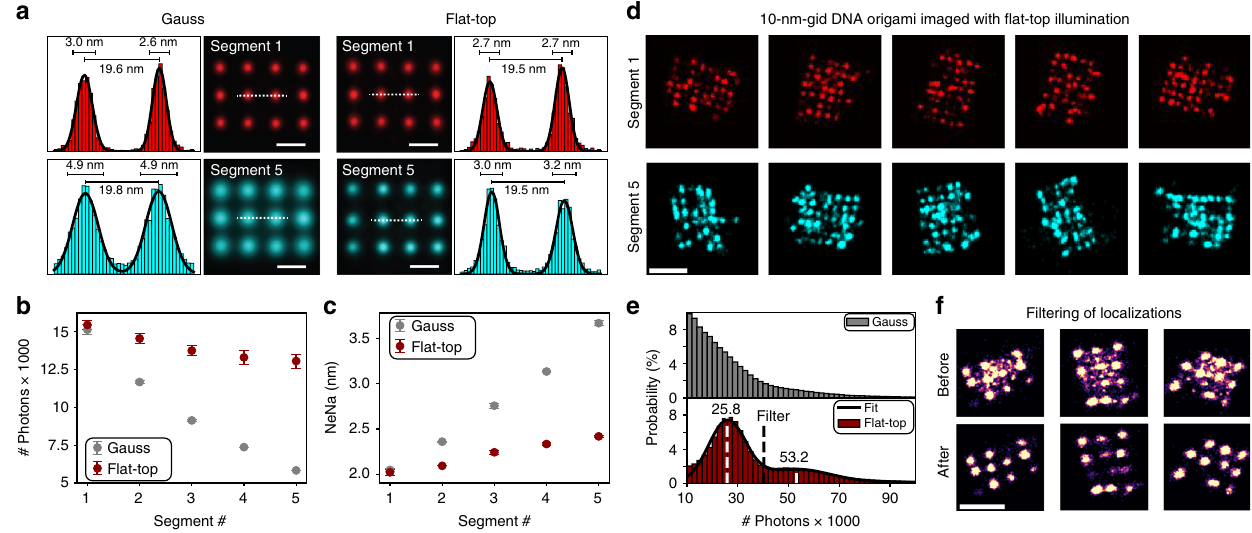
Fig. 3 Localization precision of 2 nm over 130 × 130 µ m 2 FOV with fl at-top illumination. a Averaged images of 20-nm-grid structures (~800 per segment, see Fig. 2c for de fi nition of segments) show radial decrease in resolution using Gaussian illumination, while fl at-top illumination maintains high spatial resolution. Fit results for peak-to-peak distance and standard deviation displayed above. b Mean number of detected photons per localization per frame. c Localization precision calculated by nearest neighbor analysis (NeNA) d 10-nm-grid DNA origami design for whole-chip resolution benchmarking under fl at-top illumination. e Photon count histogram for fl at-top illumination indicating two peaks for the case of single binding and simultaneous binding events of two imager strands to a 20-nm grid. f Filtering out simultaneous binding events above single binding threshold ( fi lter in e set 1/ e 2 value of fi rst distribution) allowing the removal of “ cross talk ” localizations in between two active docking strands. Scale bars, 20 nm in a , 50 nm in d and f . Error bars in b and c correspond to